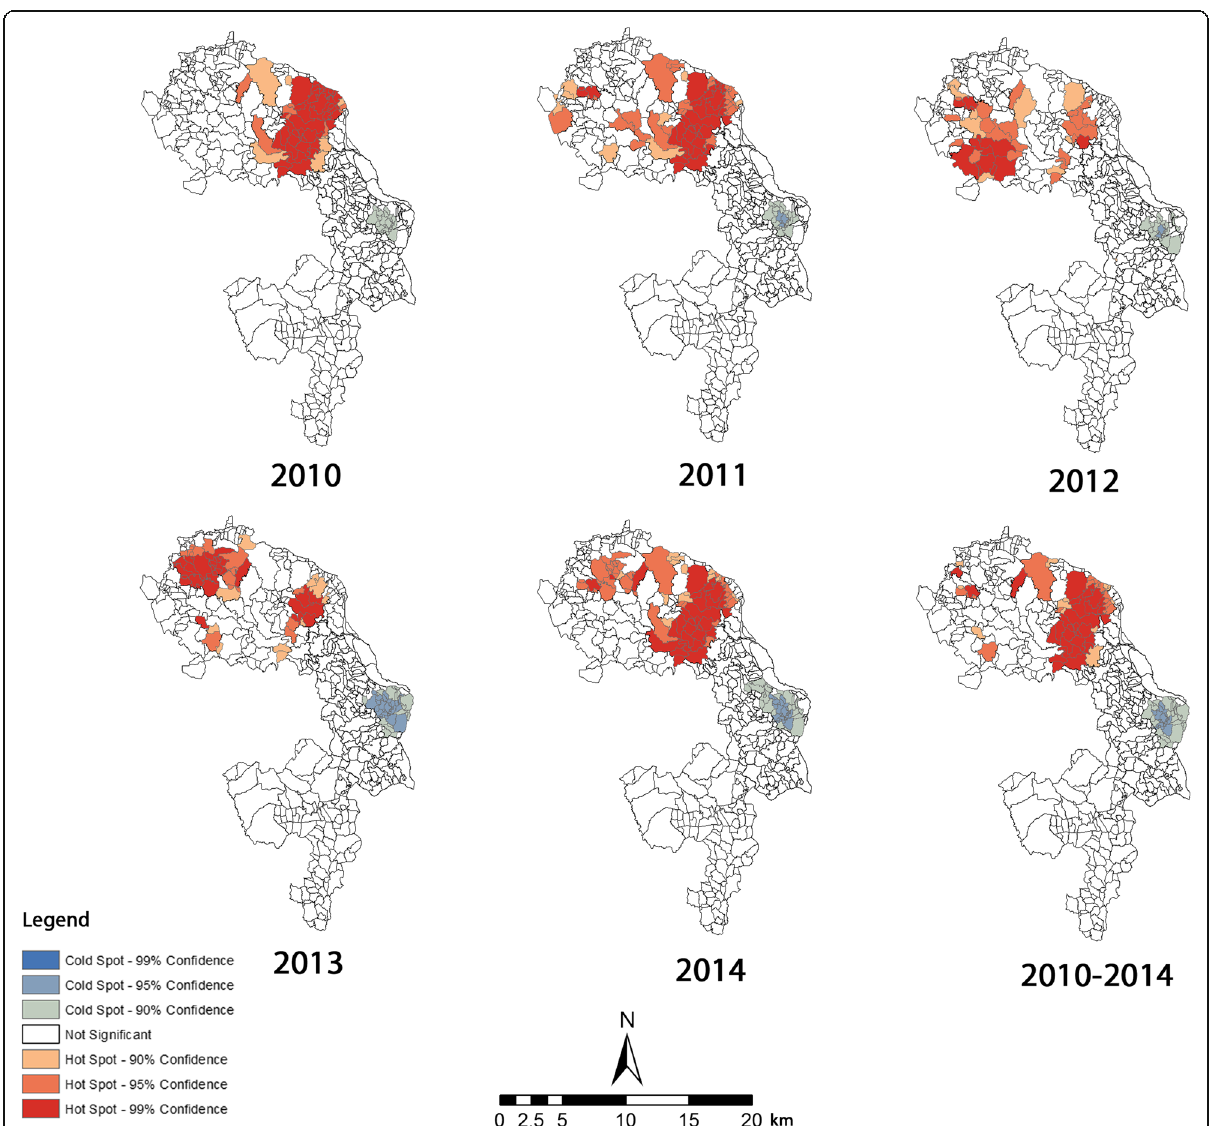
Fig. 2 Statistically significant hot and cold spots of VL in the study area, between 2010 and